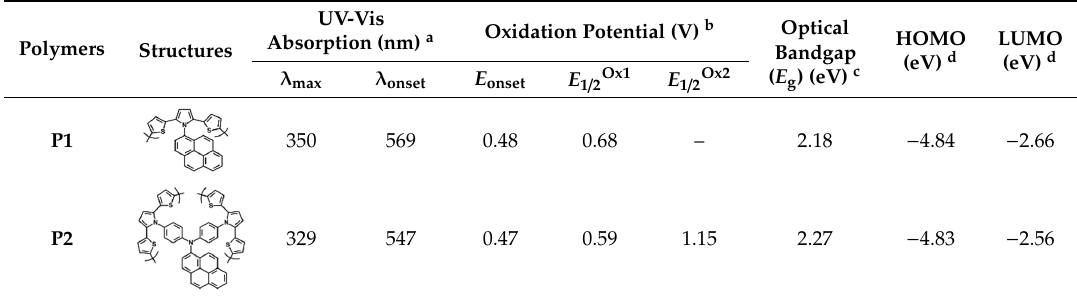
Table 1. Optical and electrochemical properties of the electrosynthesized polymers. Polymers